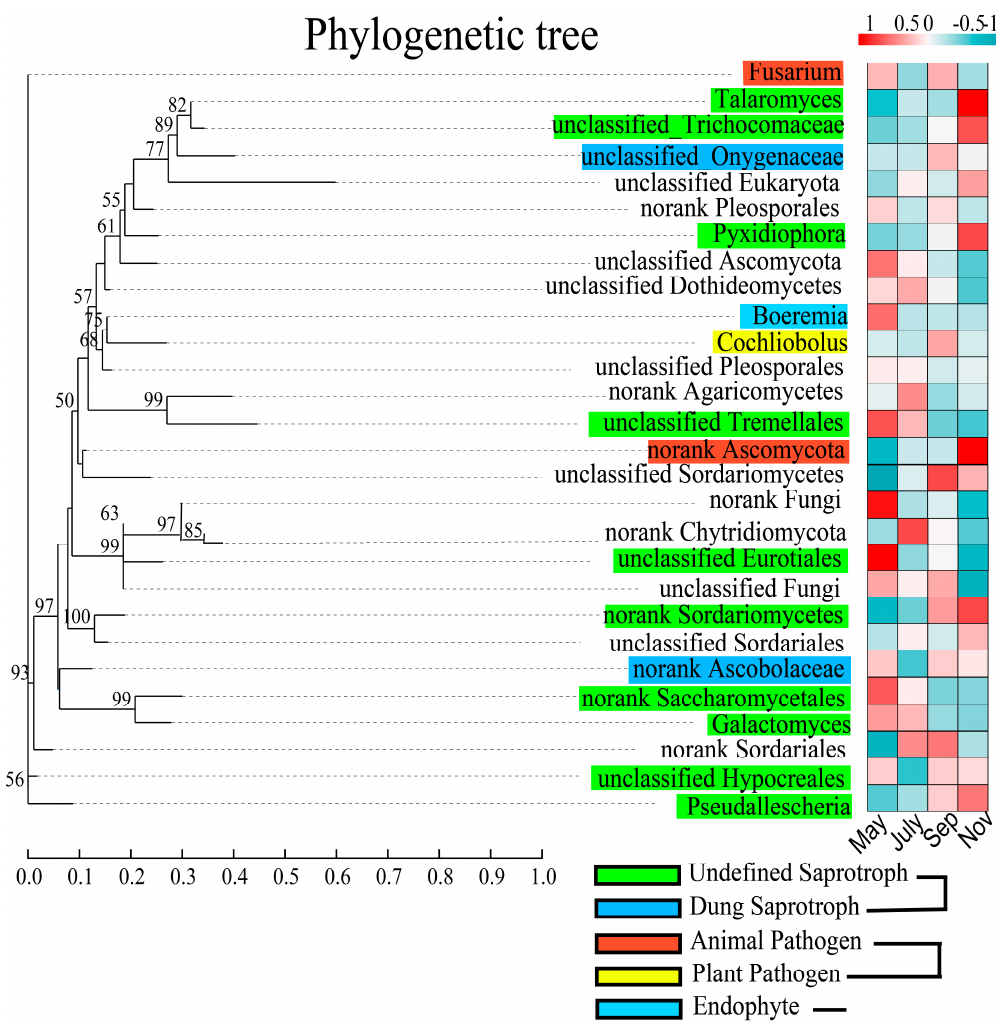
Figure 8. Phylogram with fungal guilds of the top 28 fungal genera, color the branches according to the phylum level to which the species belongs; maximum likelihood tree for the sequences obtained through high-throughput sequencing. The relative abundance data were normalized using the Z-score method, and then the average of the relative abundance of each genus for each group of samples was plotted as a heat map, the bar chart showed the percentage of Reads for the species in different stages. Guild annotation used the FUNGuild database.